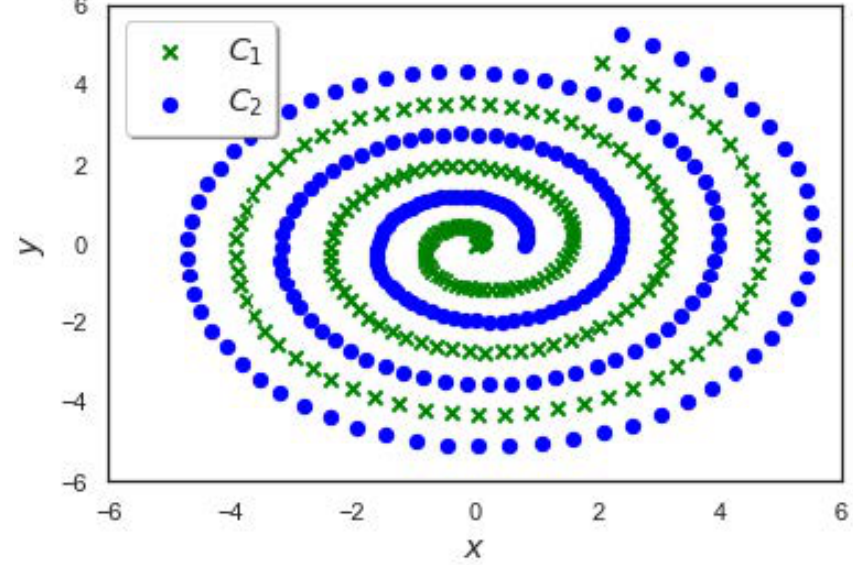
Figure 6. Training sample of two-spiral